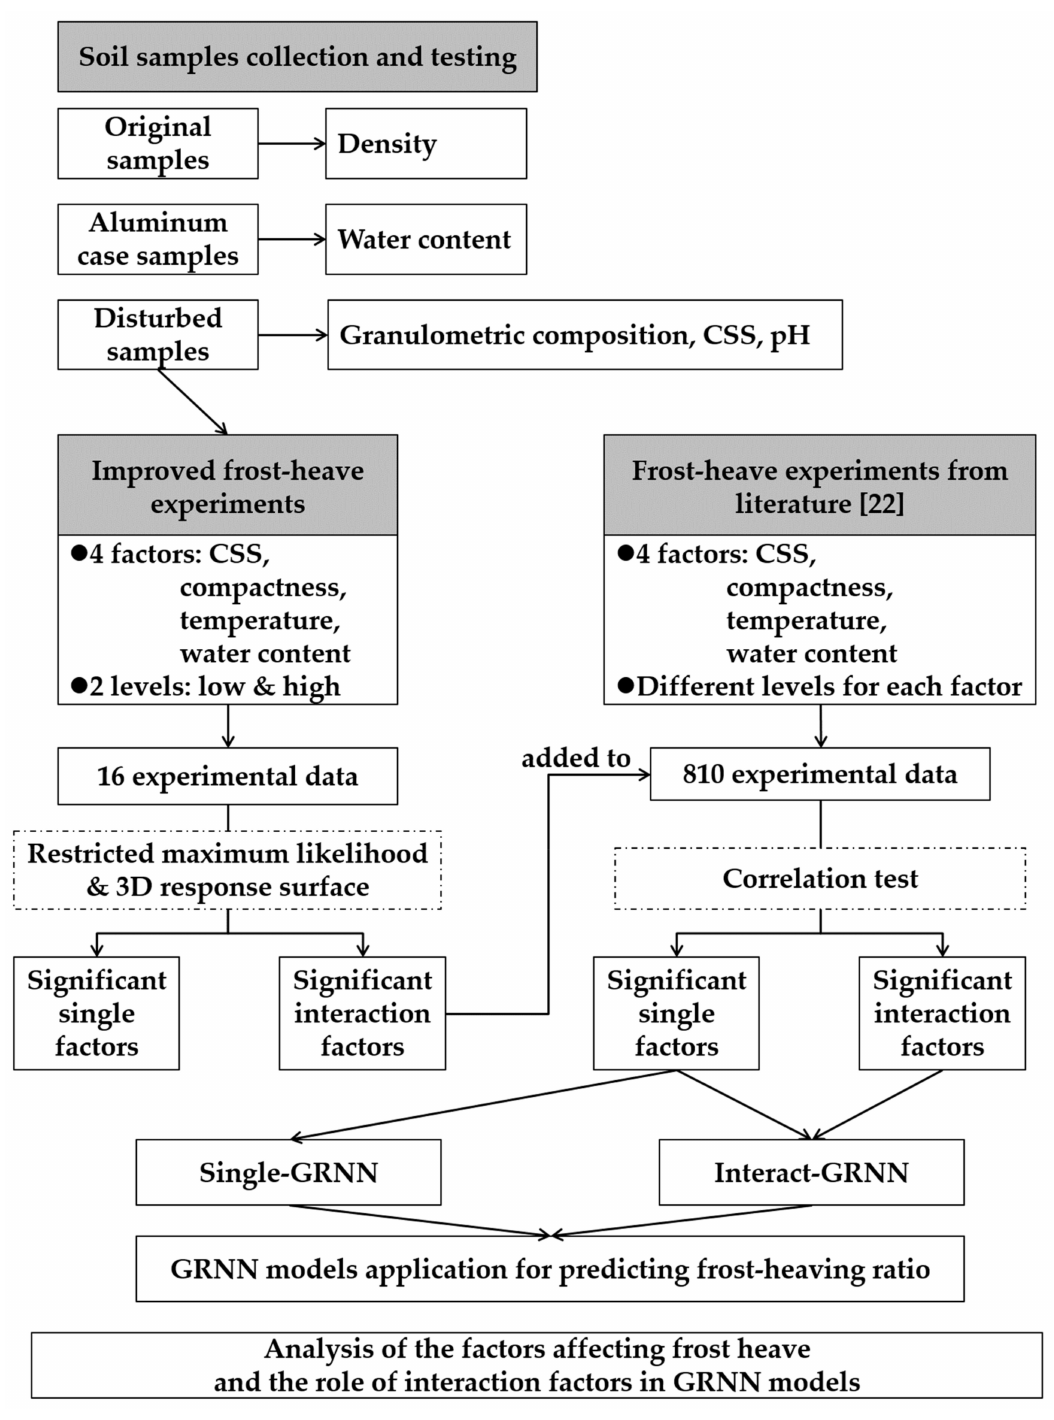
Figure 1. Technology route map of the study